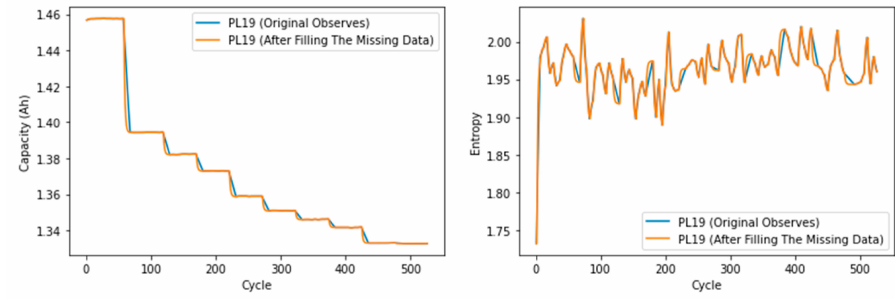
Figure 3. Capacity vs. Cycle ( left ) and Entropy vs. Cycle ( right ) for PL19.